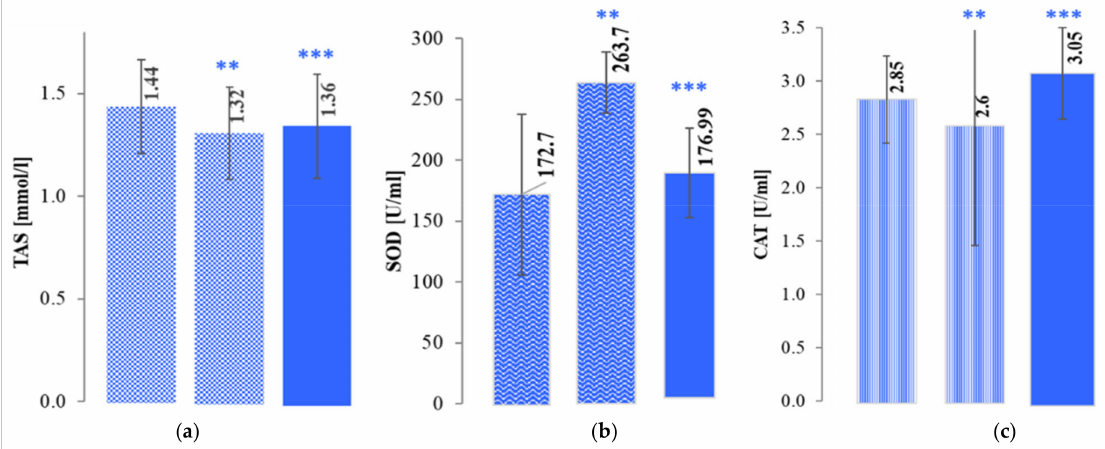
Figure 14. The activity of ( a ) TAS, ( b ) SOD and ( c ) CAT in the control group, the post-chemoradiotherapy group (**) and the post-chemoradiotherapy group with the copper(II) complex 1